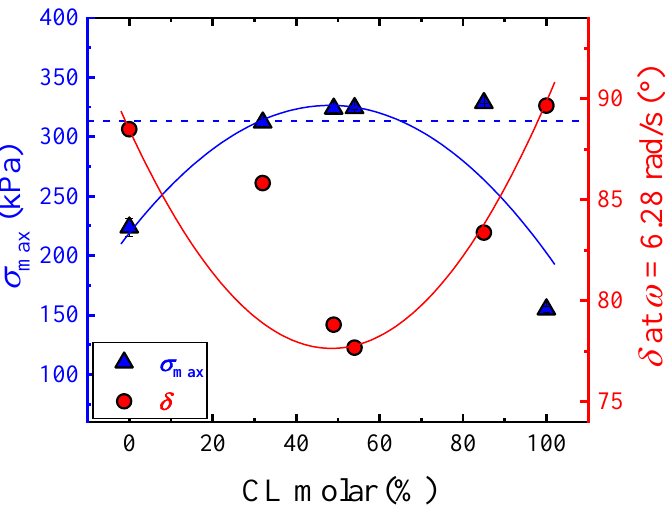
Figure 9. Stress at peak, σ max , obtained at a debonding velocity of 0.314 mm/s ( ω = 6.28 s − 1 ) and phase angle δ obtained at ω = 6.28 rad/s, as a function of composition. The horizontal segmented line corresponds to the E value of the Valco adhesive. The solid lines are guides to the eye.